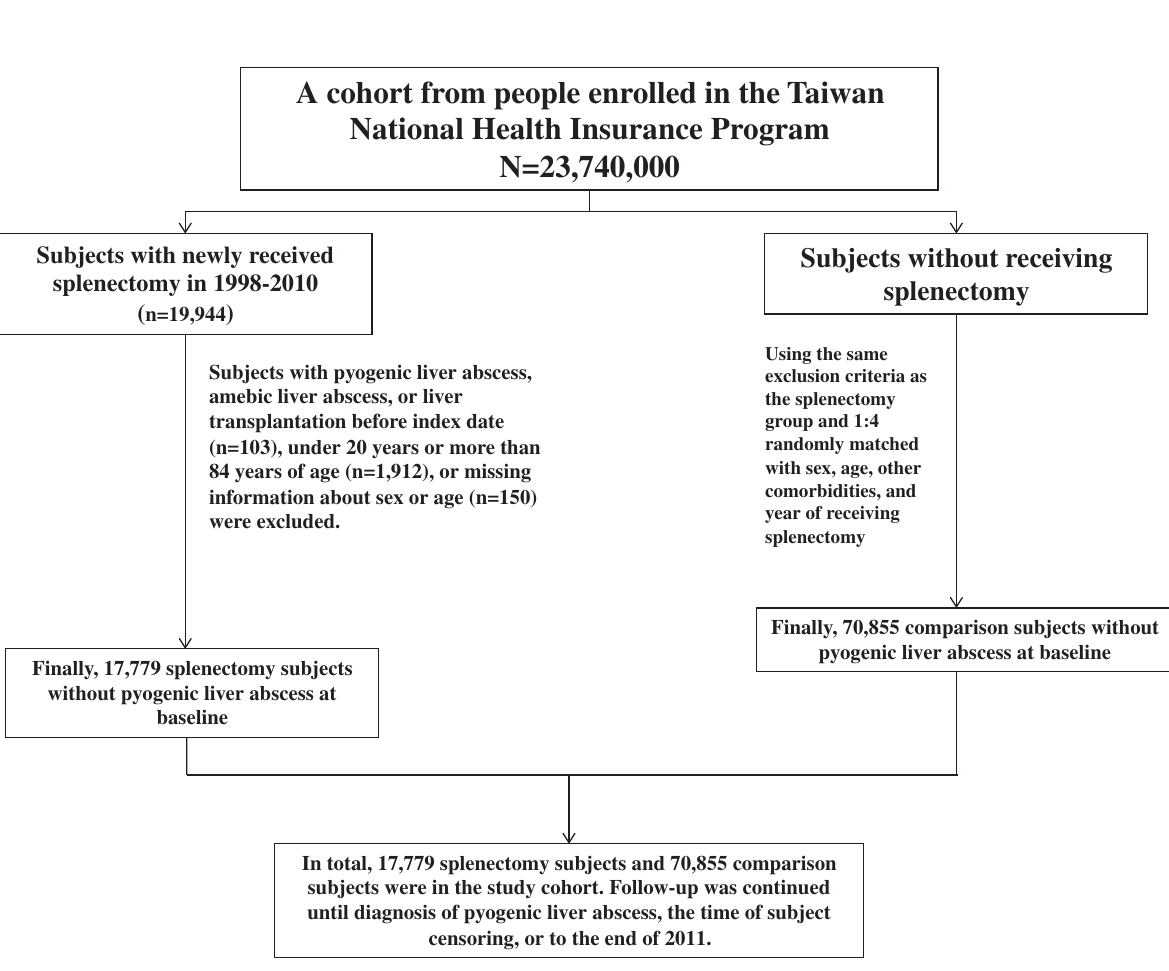
Figure. Flow chart depicting the selection process for study Table 1. Baseline information between splenectomy group and non-splenectomy group